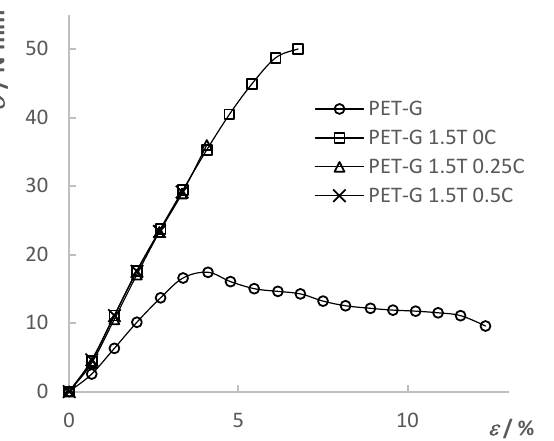
Figure 9. Tensile test results of PET-G and PET-G/1.5% TiO 2 composites with added CNT ratios .